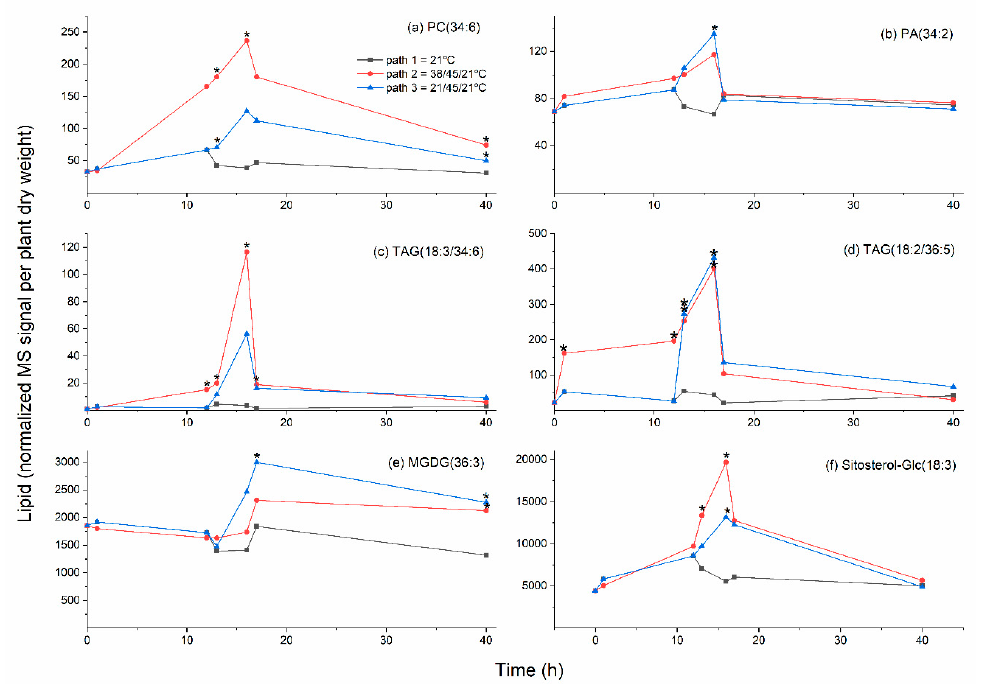
Figure 7. Levels of additional lipid species as a function of time during control and heat stress treatments. Treatment details are shown in Figure 1. ( a ) PC(34:6); ( b ) PA(34:2); ( c ) TAG(18:3/34:6); ( d )